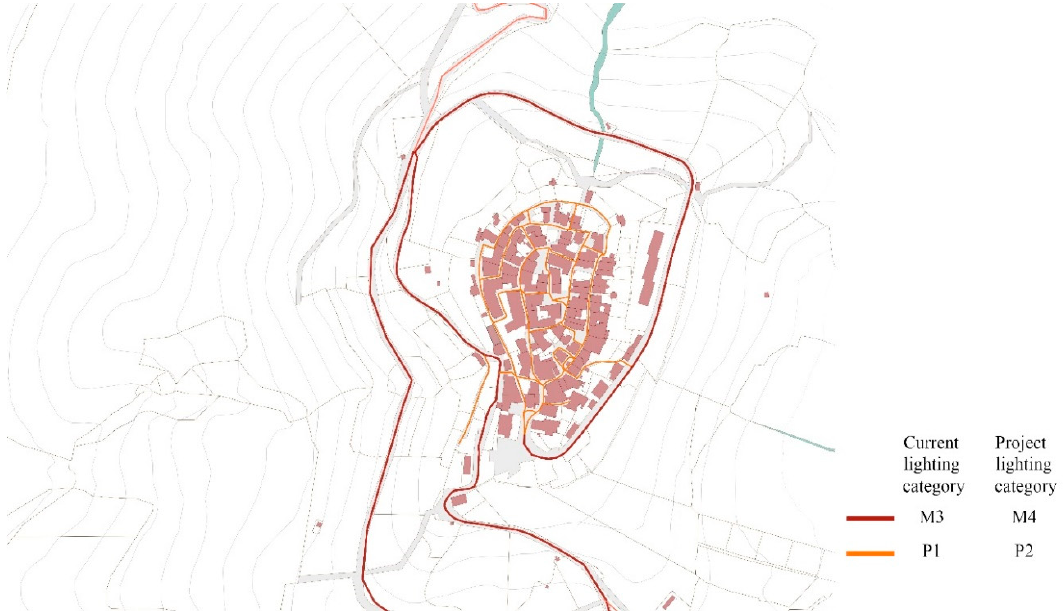
Figure 9. Road lighting classes (ex-ante and ex-post).